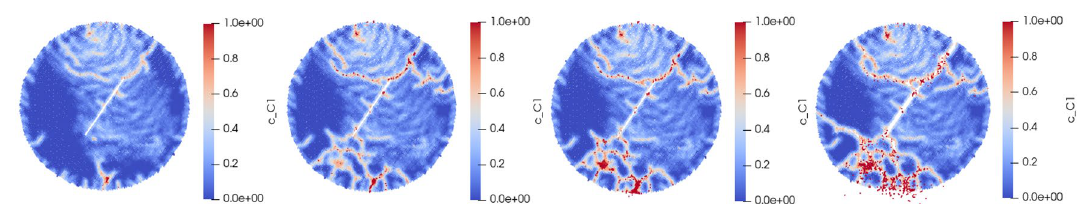
Figure 11. Shear energy change and damage of prefabricated 60° cracked rock